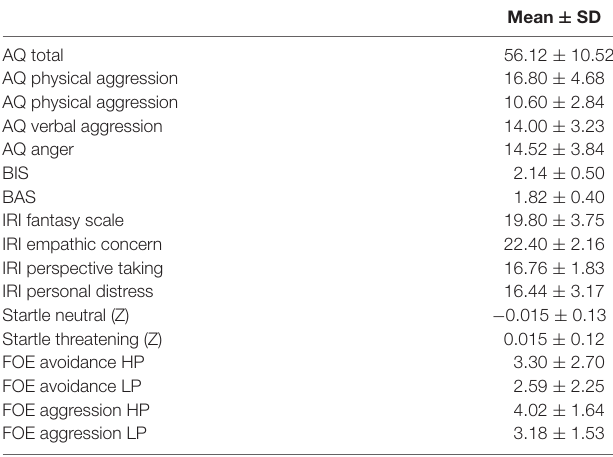
TABLE 1 | Descriptive statistics for variables in Experiment 1 ( n =